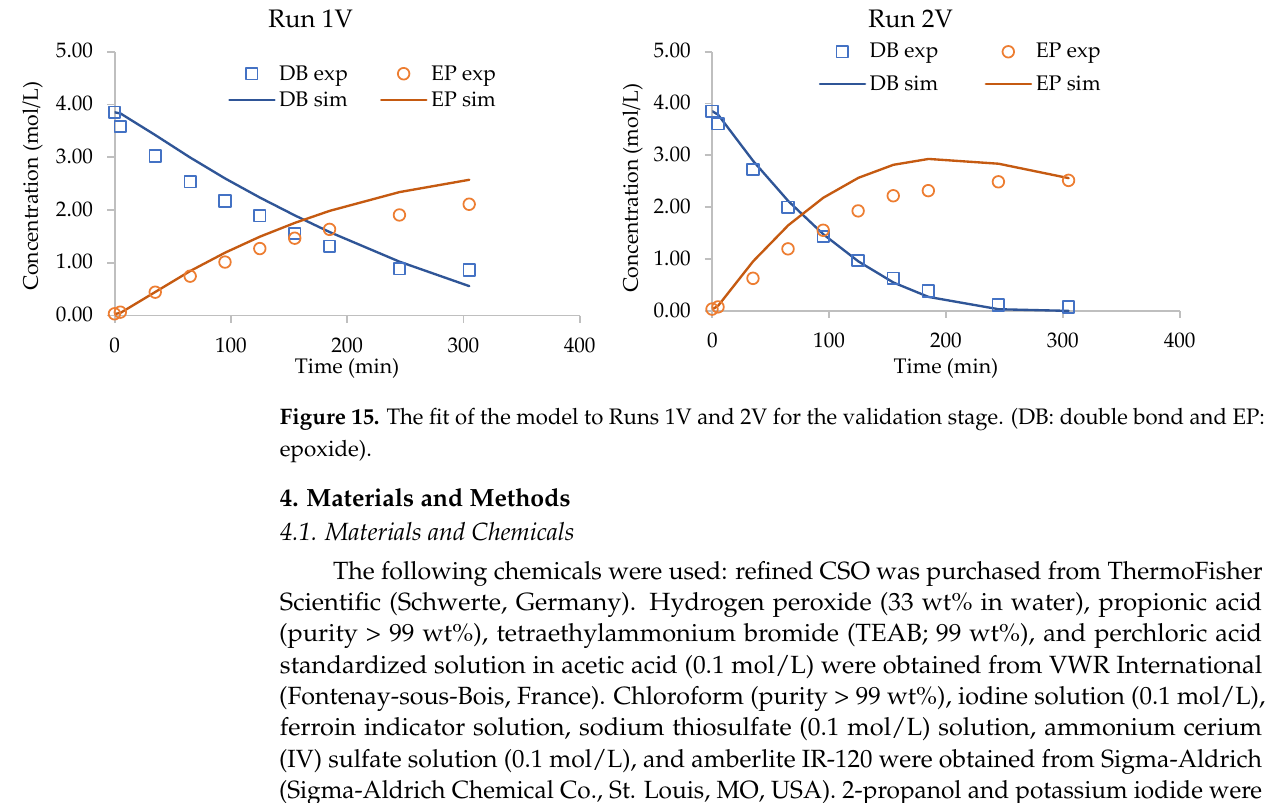
Figure 14. Parity plots for [PA] aq , [PA] org , [PPA] aq , [HP] aq , [EP] org , and [DB] org from the kinetic model of propionic acid perhydrolysis over Amberlite IR-120 for Runs 1V and 2V. (DB: double bond, EP: epoxide, PPA: perpropionic acid, PA: propionic acid, and HP: hydrogen peroxide).